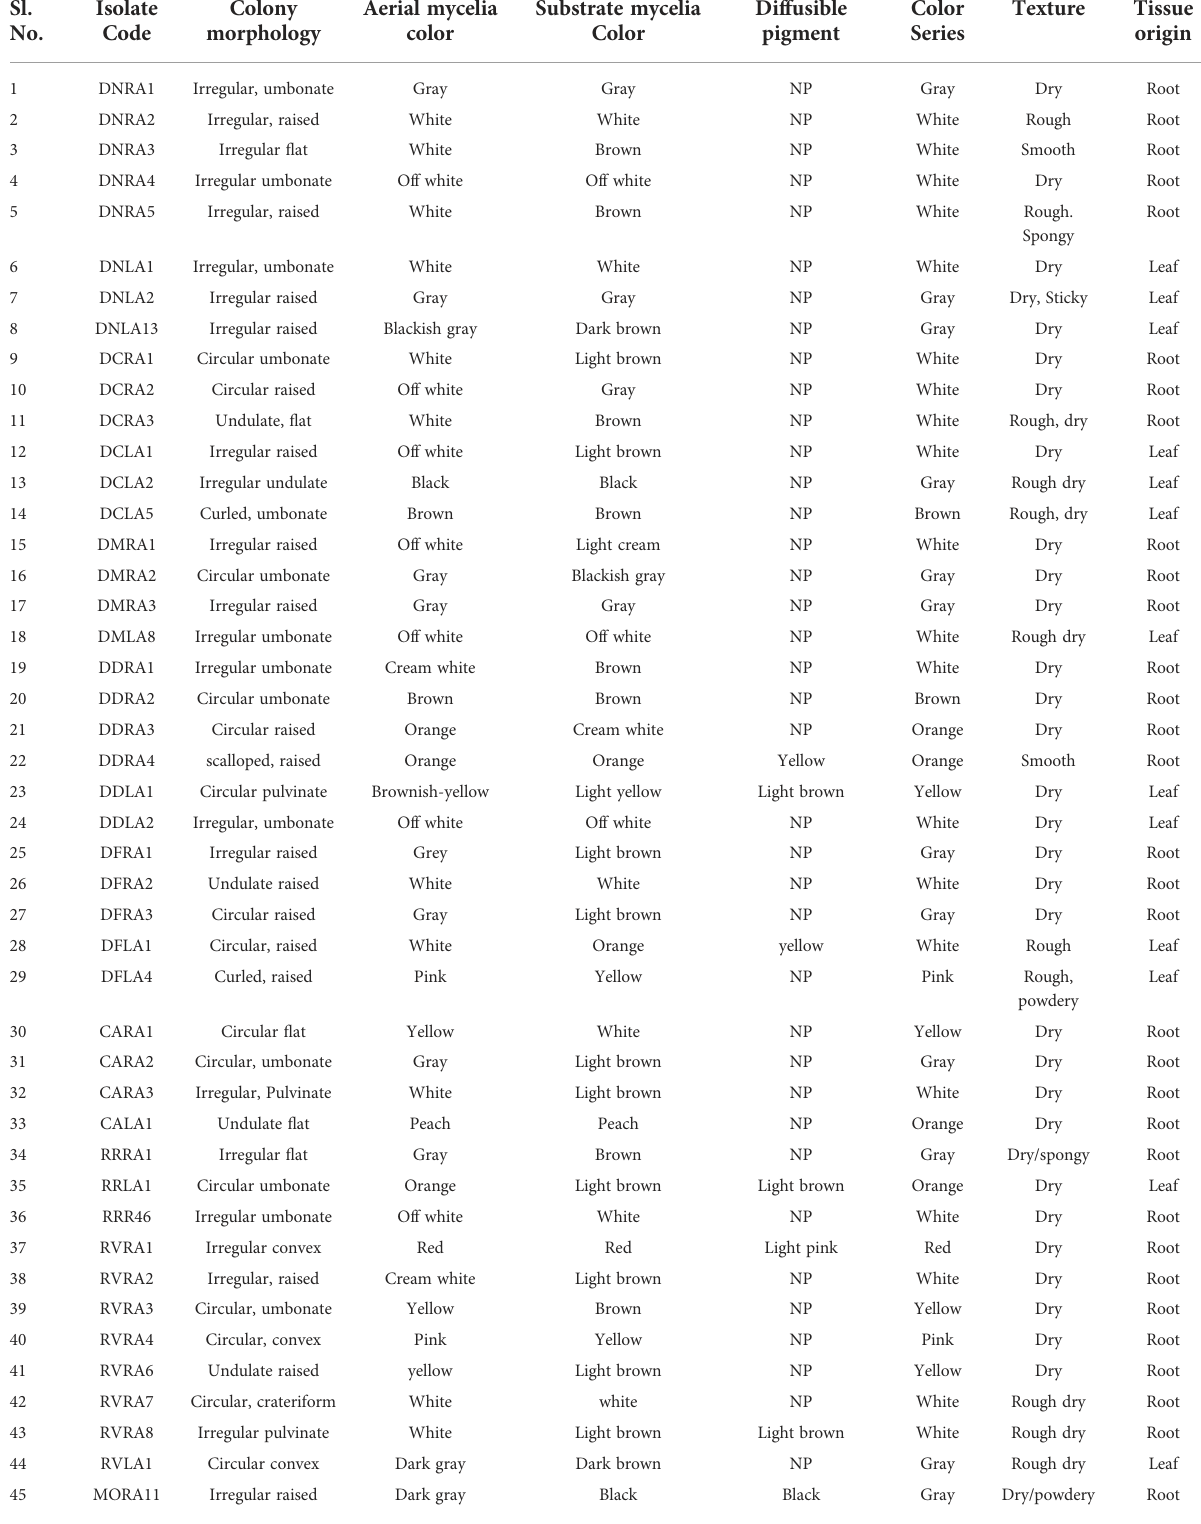
TABLE 1 Morphological characterization of endophytic actinobacteria isolated from ten orchid species of Assam on the basis of phenotypic traits.